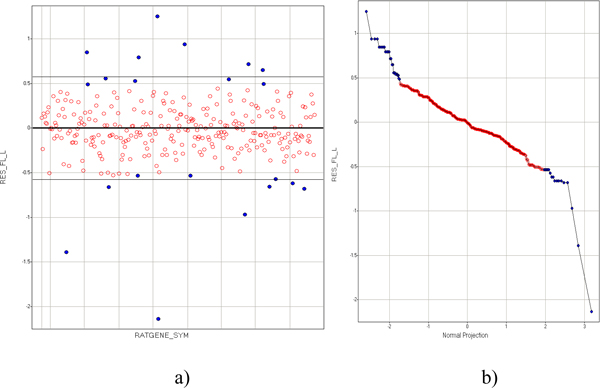
Determination of outliers in correlated variables FC_CTRL_FL and FC_CTRL_L. a) Plot of residuals RES_FL_L distributed over each protein identified by Ratgene_sym. The thick line and the two thin straight lines above and below are average and +/-2 standard deviation lines. Residual fold changes for each protein i were calculated using the linear regression model shown in Table 2 and calculated using the following formula:Residue (i) = FC_CTRL_FL(i) - (a* FC_CTRL_L(i) + b), where FC_CTRL_FL(i) and FC_CTRL_L(i) refer to FC for FL_vs_CTRL and FC for L_vs_CTRL for a given protein i, respectively. b) Normal probability plot of residual variable RES_FL_L over normal projection. The outliers are indicated as blue solid dots in both panels. The normally distributed data points are indicated as red empty circles in both panels.